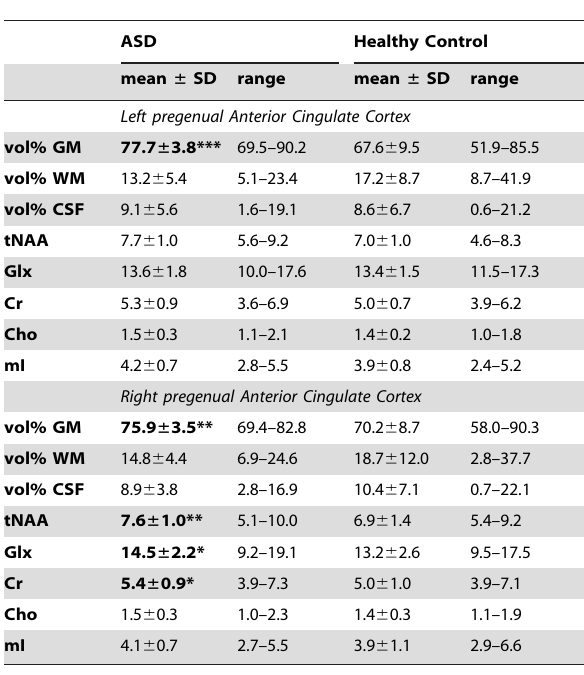
Table 4. Experiment 2: Voxel tissue content and proton magnetic resonance spectroscopic imaging ( 1 H MRSI) metabolite levels in bilateral pregenual anterior cingulate cortex (pACC) voxel.